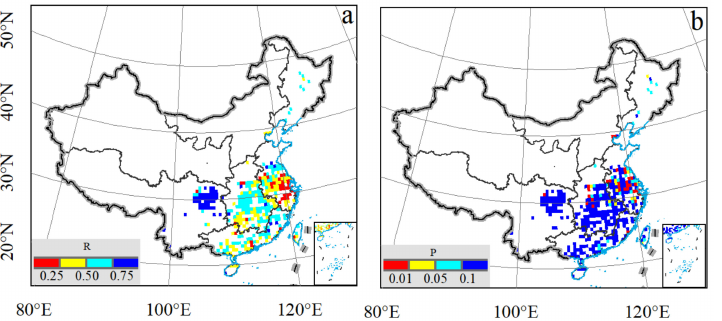
Figure A4. Monthly variations of methane emission of six categories from EDGAR over China.